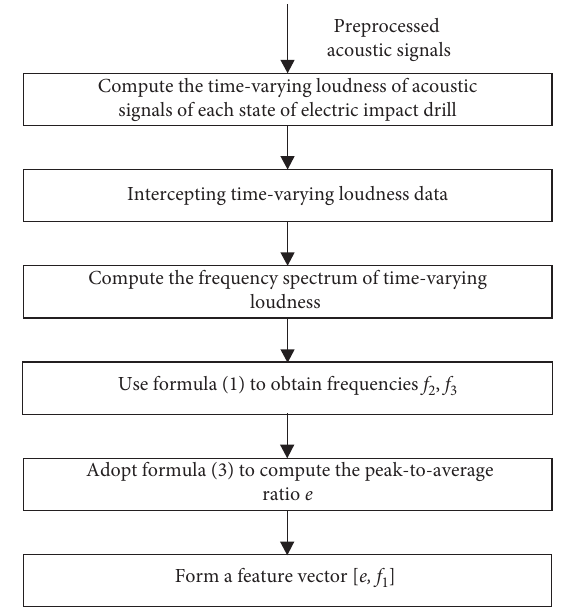
Figure 6: Flowchart of the peak-to-average ratio (PAR) model based on the time-varying loudness